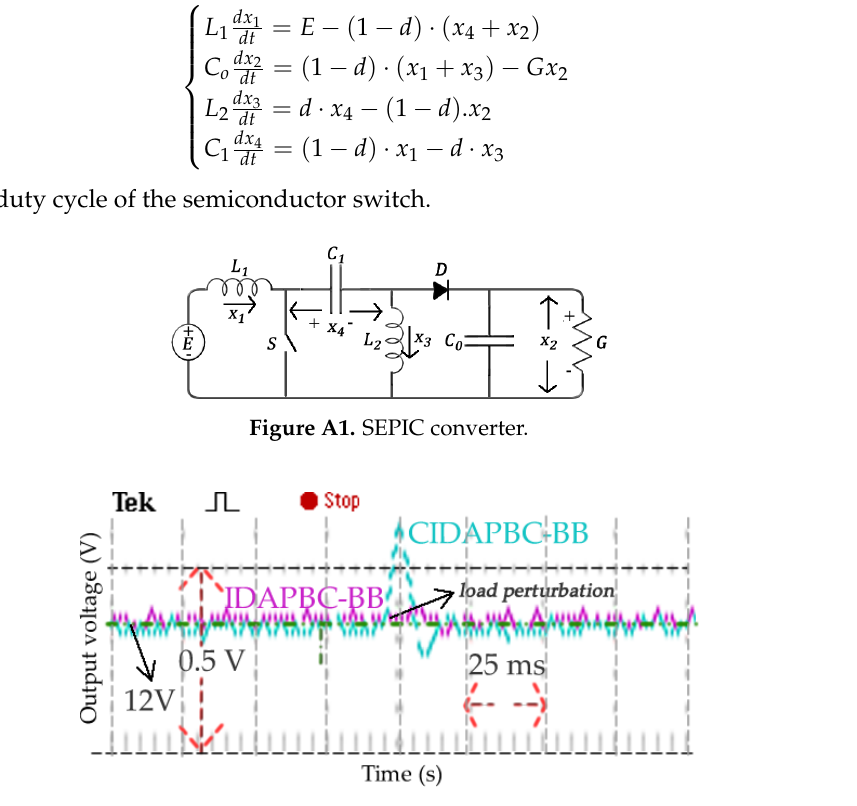
Figure A2. SHIL result for SEPIC: IDAPBC-BB (magenta) and CIDAPBC-BB (cyan). Normalized output voltage x 2 for load perturbation